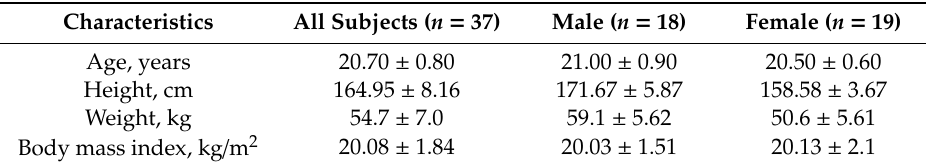
Table 1. Basic characteristics of